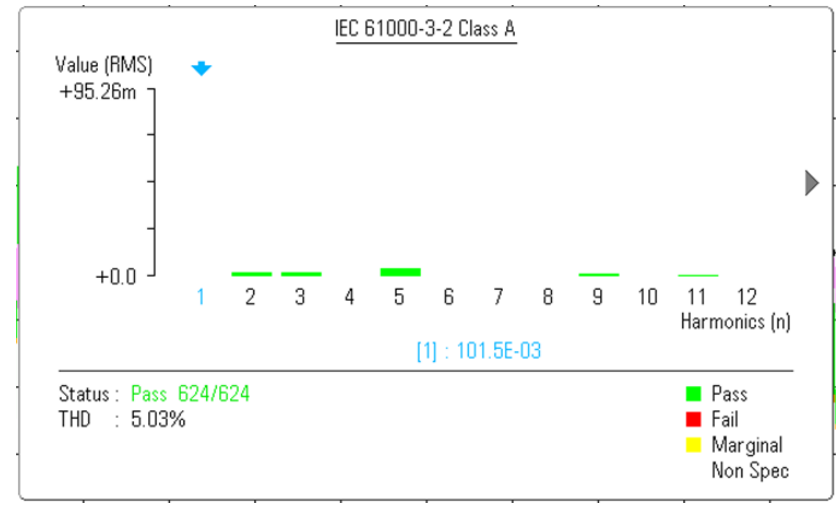
Figure 21. FFT analysis of circulating current in MMC.